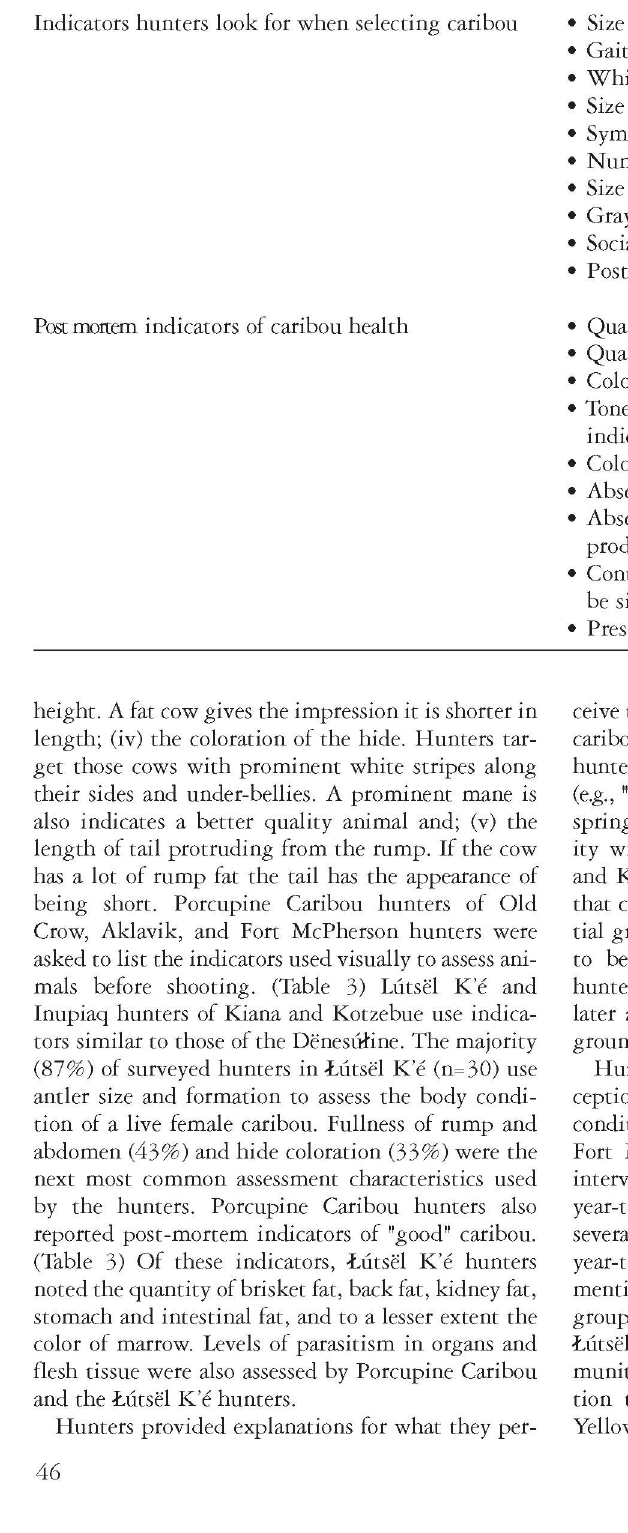
Table 3. Indicators of good caribou body condition and overall health, and reported by indigenous Porcupine Caribou hunters (Kofinas 1998: